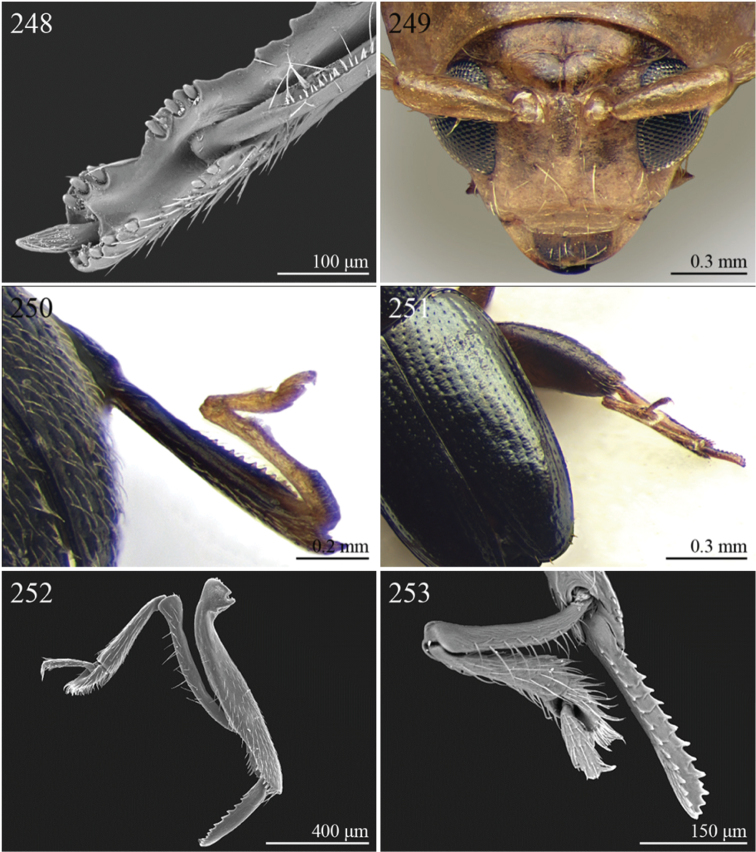
Morphological characters. 248
Psylliodes teresae Biondi, apical part of hind tibia and preapical insertion of metatarsus 249
Sanckia sp., head in frontal view 250
Sanckia longicornis (Jacoby), hind leg 251
Serraphula grobbelaariae Biondi & D’Alessandro, hind leg and elytral punctation 252
Serraphula elongata Jacoby, hind leg 253
Serraphula audisiana Biondi & D’Alessandro, serrate apical spur of hind tibiae.